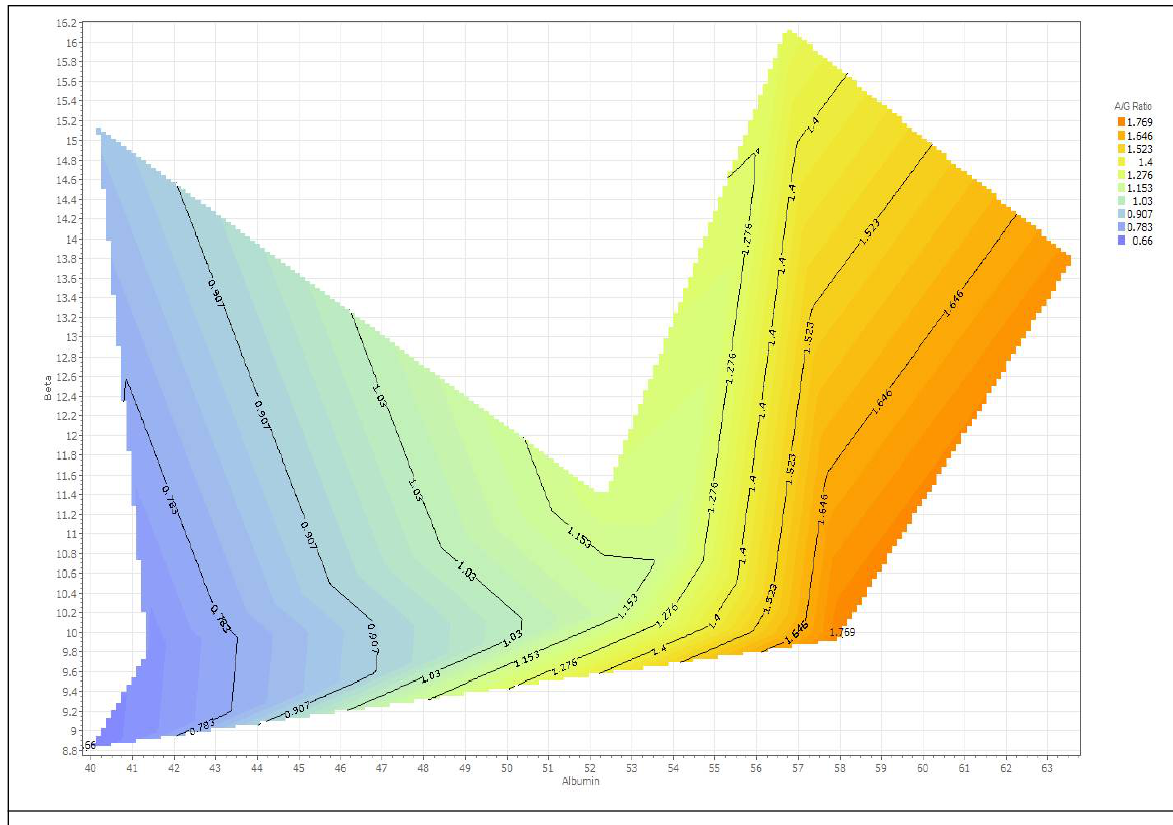
Figure 12: Variation of A/G ratio with respect to albumin and beta